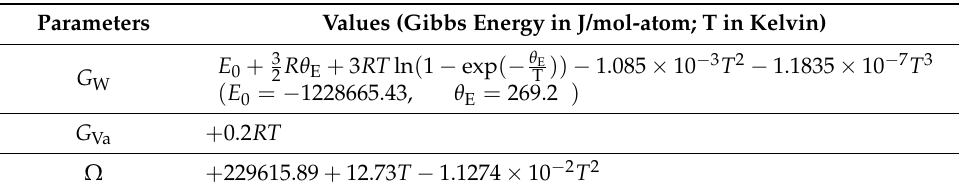
Table 1. List of the evaluated thermodynamic parameters for bcc W.